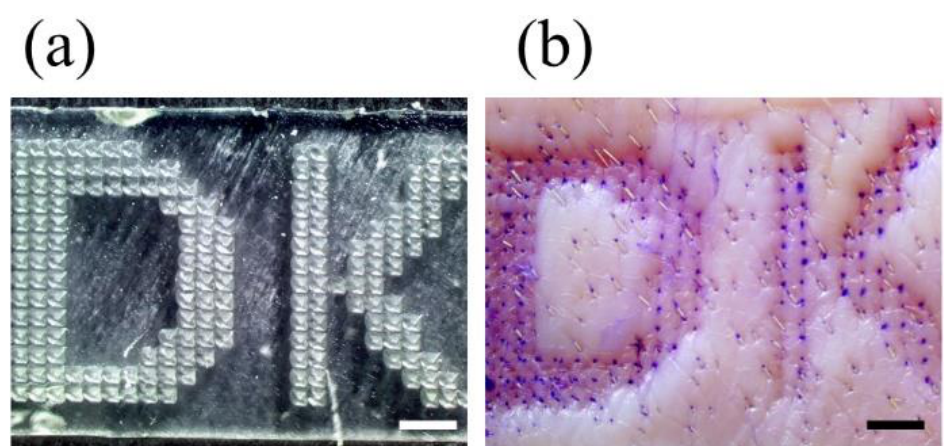
Figure 9. The letter type microneedle arrays were measured by a stereomicroscope ( a ). The skin penetration image of the array into the porcine skin ex vivo ( b ) (scale bars are 2.0